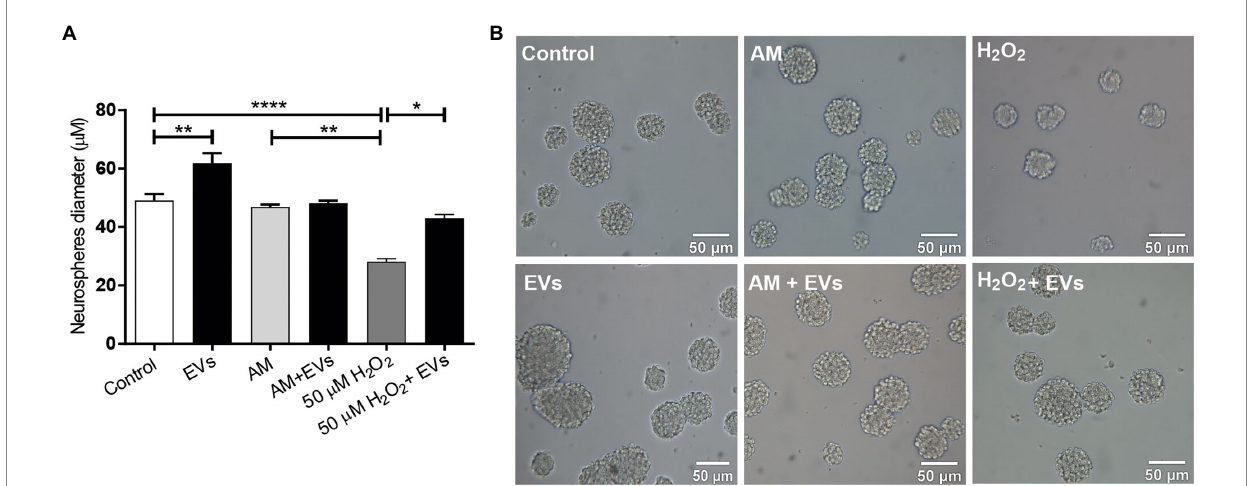
FIGURE 2 NSC-EVs regulate NSCs proliferation. (A) After incubating the NSCs under the indicated conditions (H 2 O 2 50 μ M; AM: activated inflammatory media) in the presence or in the absence of extracellular vesicles (NSC-EVs) during 96 h, proliferation was analysed by measuring neurosphere’s diameter. Graph represents the neurosphere’s diameter measured in three independent experiments. Data were presented as mean ± SEM. **** p < 0.0001; ** p < 0.01; * p < 0.05. (B) Representative images (20X) of neurospheres incubated in the indicated conditions. Scale bars: 50 μ m.